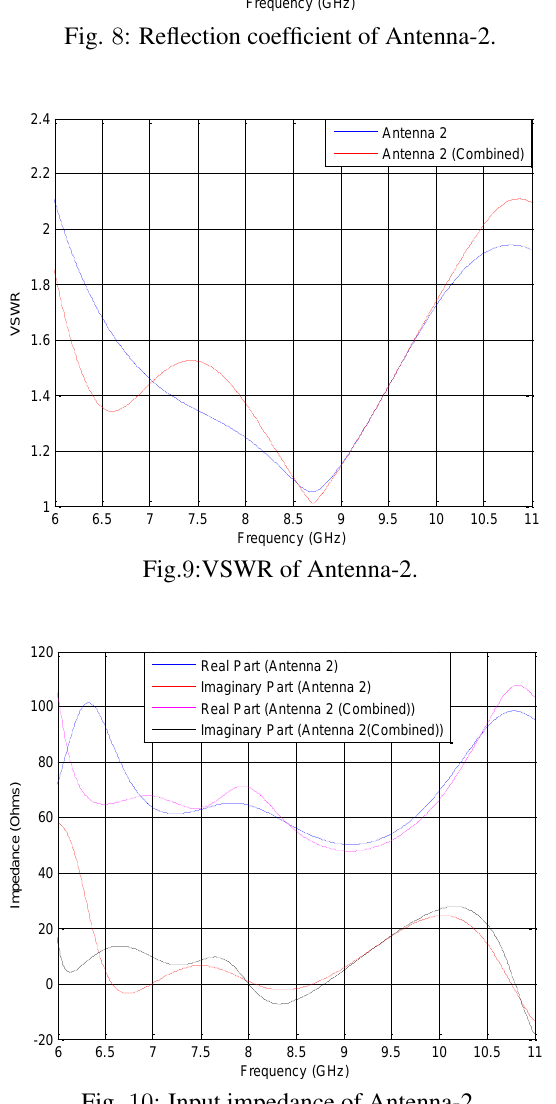
Fig. 10 : Input impedance of Antenna-2. The combined antenna is simulated and measured. The simulated and measured reflection coefficient of the com- bined antenna is shown in